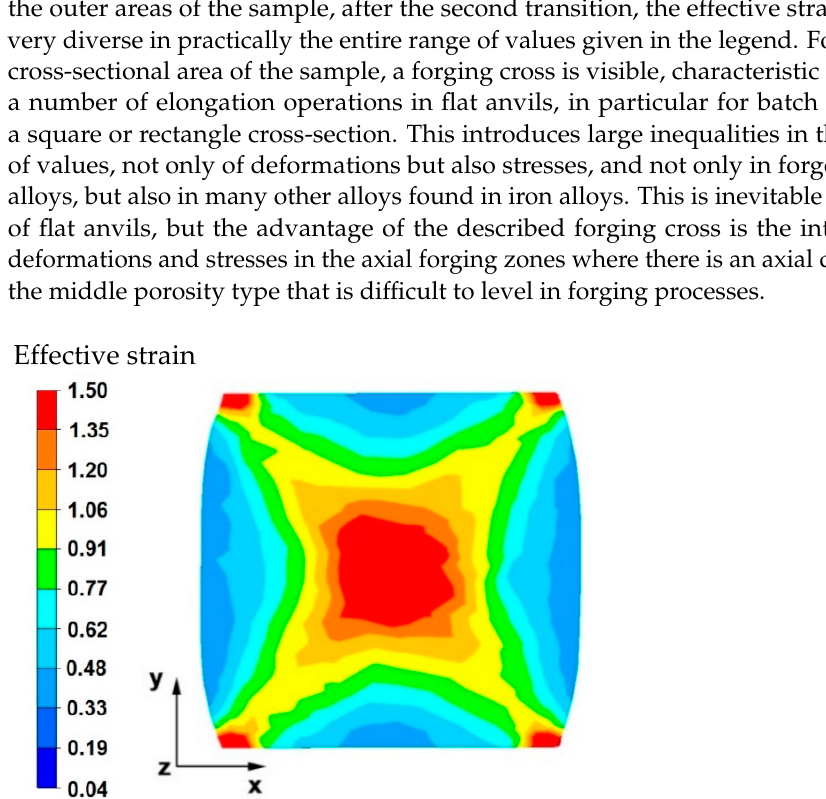
Figure 15. Distribution of the effective strain values on the surface of the cross-section of the sample with modeled discontinuity after rotation by 90° and re-deformation with 35% reduction.